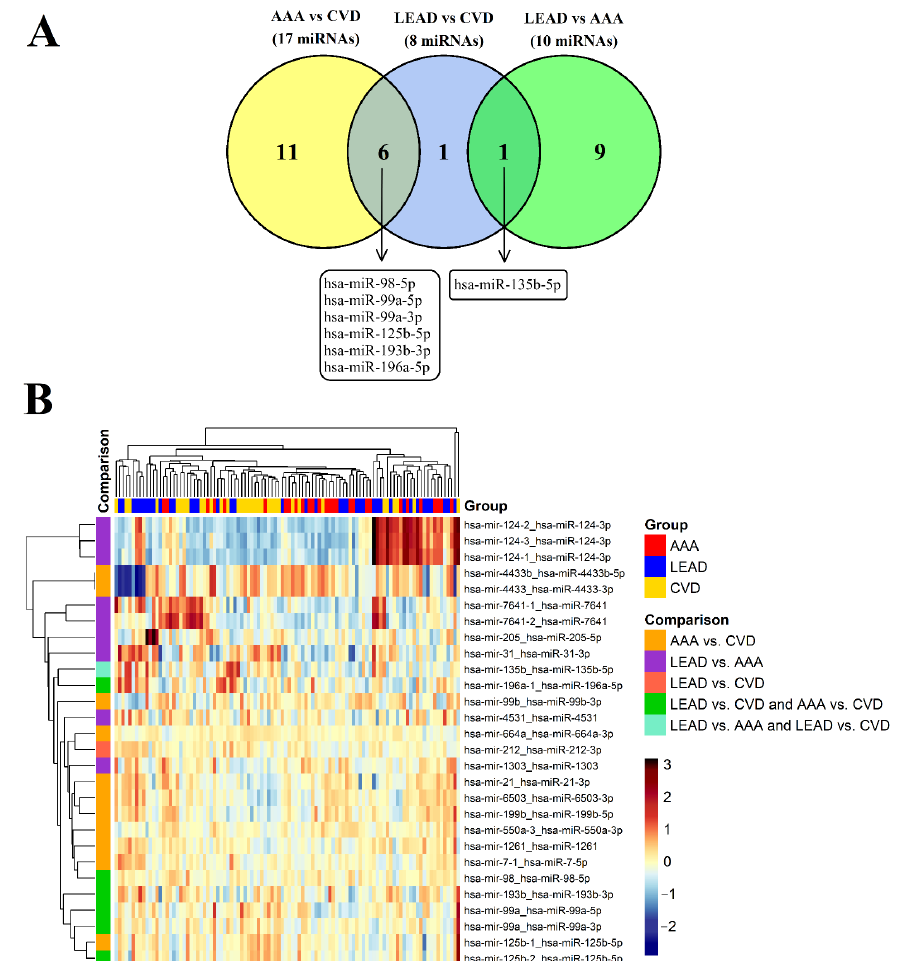
Figure 1. The comparison of the sets of differentially expressed miRNA transcripts selected from pairwise comparative analysis performed among the LEAD, AAA, and CVD groups using DESeq2 method. ( A ) The comparison of the sets of miRNA transcripts selected from LEAD vs. CVD, LEAD vs. AAA, and AAA vs. CVD comparisons using the following selection criteria: p -value < 0.05, ab- solute log2 fold change > 1, and mean of normalized counts > 10. The number in the intersection fields of the Venn diagram represents the number of miRNA transcripts common to the compari- sons. The frames below the Venn diagram include six miRNAs common for AAA vs. CVD and LEAD vs. CVD comparisons and one miRNA common for LEAD vs. CVD and LEAD vs. AAA com- parisons. ( B ) Heatmap of the expression of 28 miRNA transcripts selected from LEAD vs. AAA, LEAD vs. CVD, and AAA vs. CVD comparisons and included in the Venn diagram in panel A. Hierarchical clustering was performed using the average method applied to Euclidean distances.